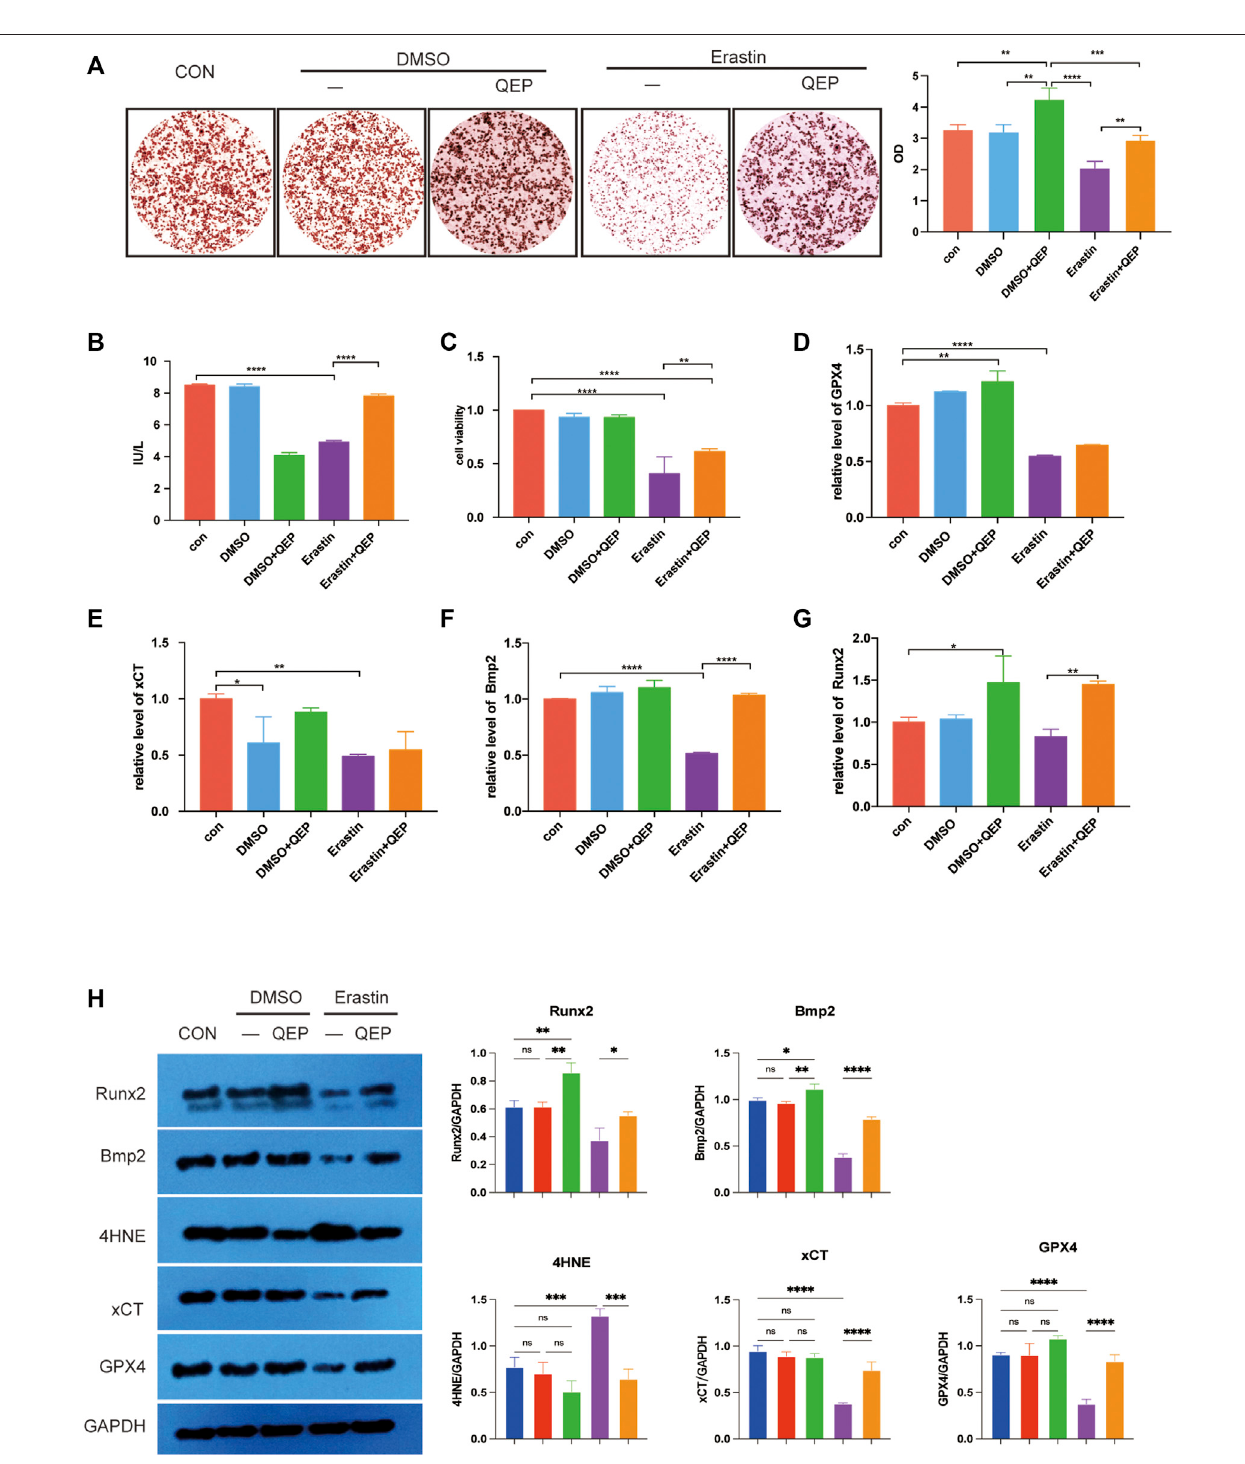
FIGURE3| EffectofQEPonosteogenicinductionandferroptosisinhFOB1.19cells. (A) AlizarinredSstaining.Theformationofmineralisednoduleswasobserved through staining. (B) Comparison of ALP levels. ALP was detected by ELISA. (C) Cell viability was detected by CCK8 assay. (D – G) Relative mRNA expression of genes related to osteogenesis and ferroptosis in different groups. (H) Western blot analyses were performed to detect the expression of osteogenesis- and ferroptosis-related proteins (Qing: QEP; * p < 0.05, ** p < 0.01, *** p < 0.001, and **** p < 0.0001).